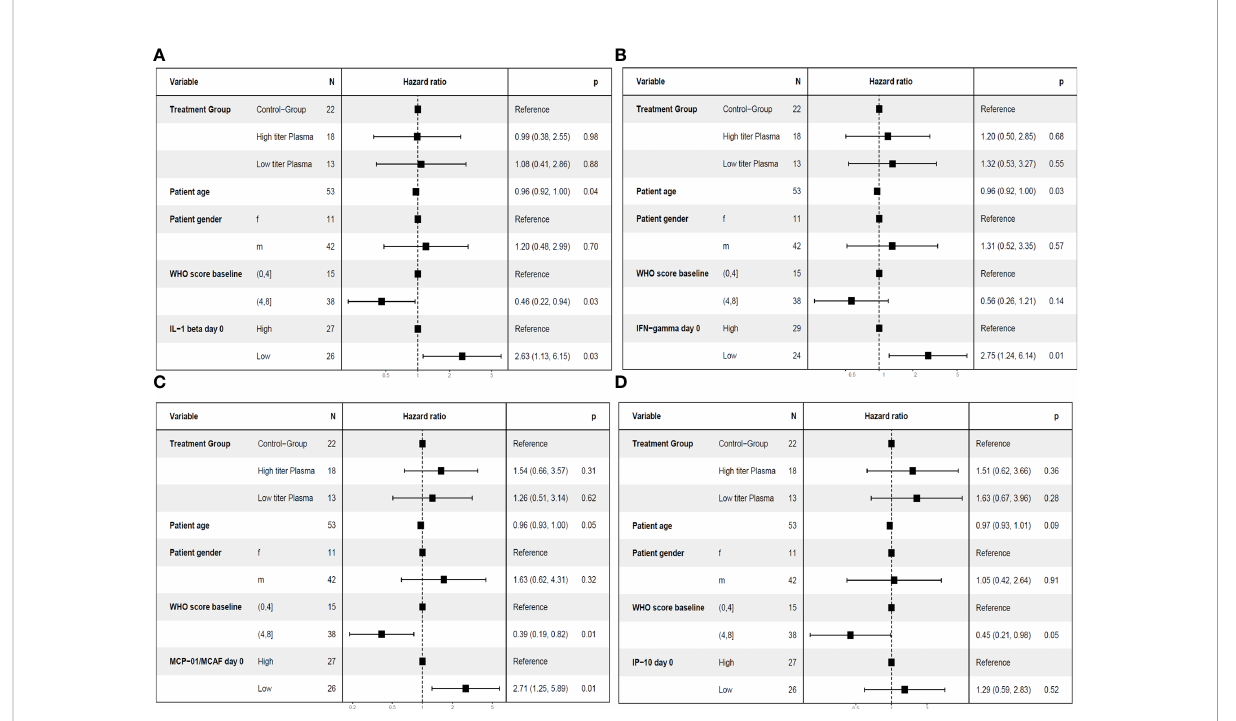
FIGURE 10 Multivariate analyses of the key secondary endpoint time to clinical improvement ( ≤ median vs. > median) including cytokine levels on day 0. The following variable were included in the model: Treatment group (control group, high titer plasma, low titer plasma), age (as continuous variable), gender, baseline WHO Severity Score ( ≤ 4 vs. > 4) (11) and the level of the respective cytokine on day 0 ( ≤ median ( “ low ” ) versus > median ( “ high ” )). One cytokine each was included in the models: IL-1ß (A) , IFN- g (B) , MCP-1 (C) or IP-10 (D)